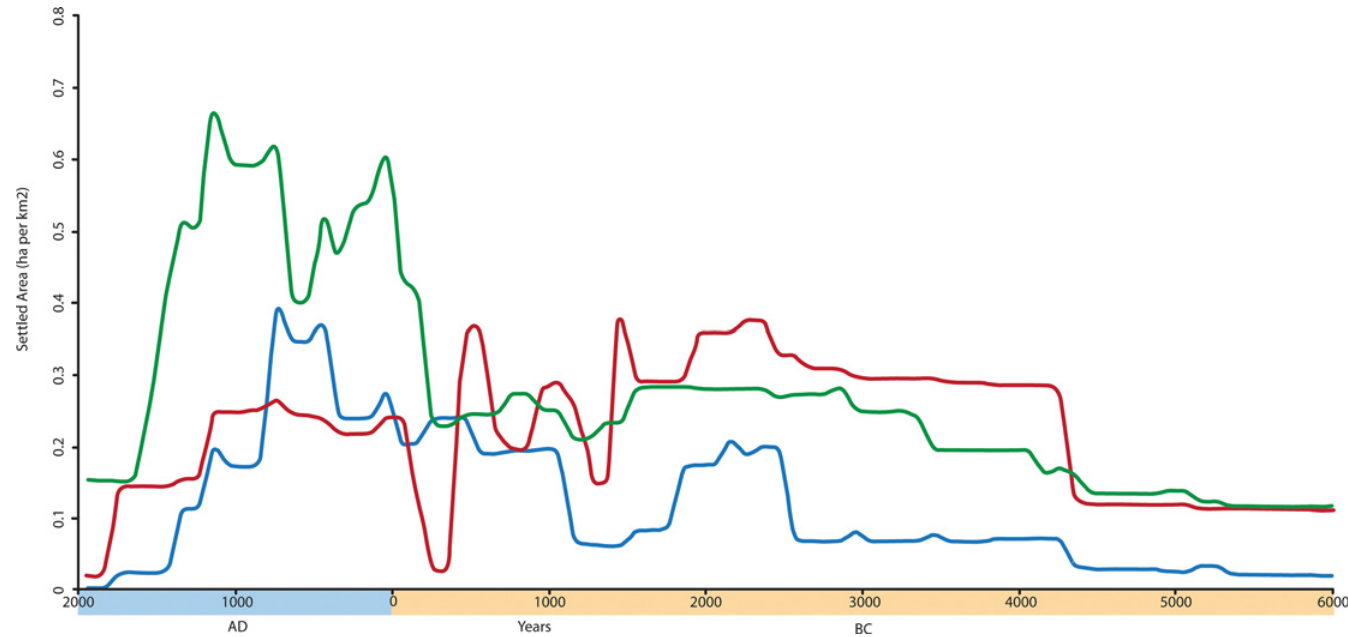
Fig 4. Aggregate settlement density for the three sub-regions of the northern Fertile Crescent expressed as settled area (hectares) per km 2 surveyed. Red line represents the East (Jazira) region, blue line the Central (Euphrates Valley) region, green line the West (Orontes Valley) region.